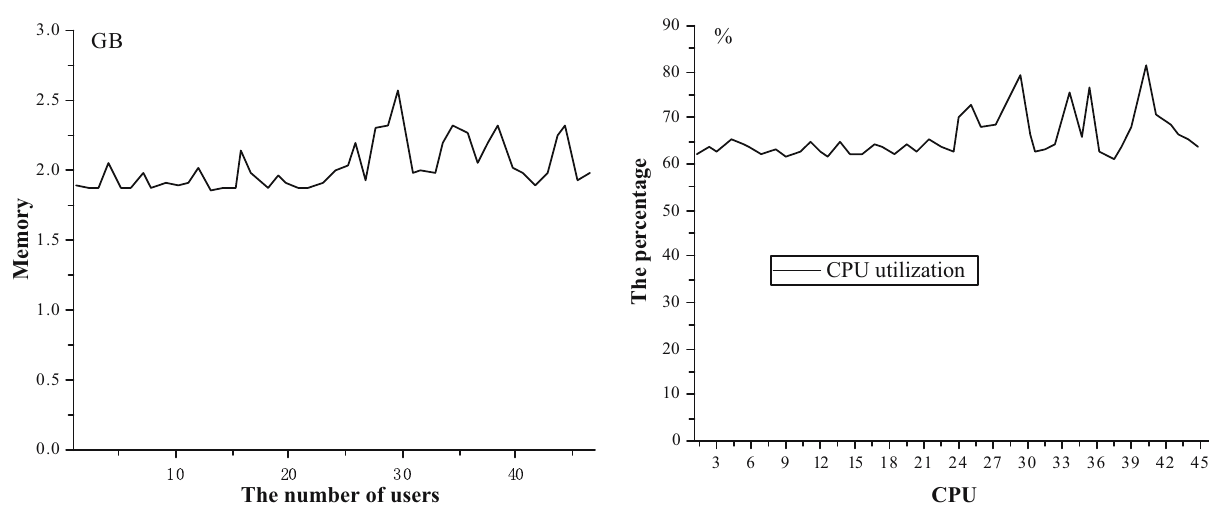
Figure 3: Curve of memory usage test results. Figure 4: Curve of CPU usage test